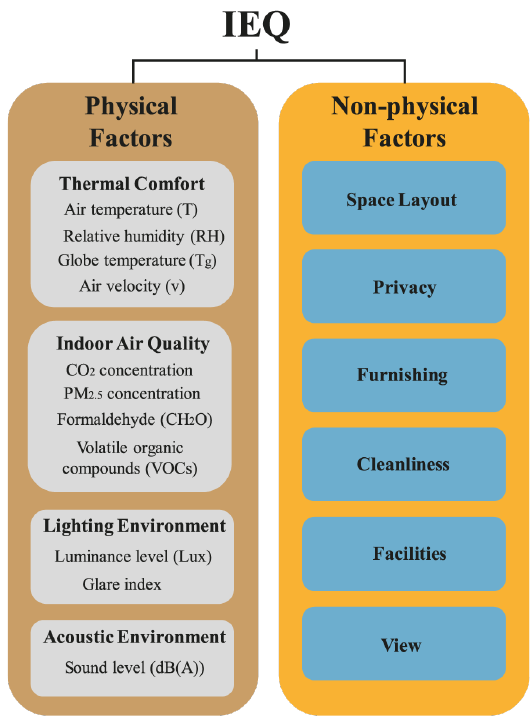
Figure 9. Physical and non-physical factors in IEQ studies [134].